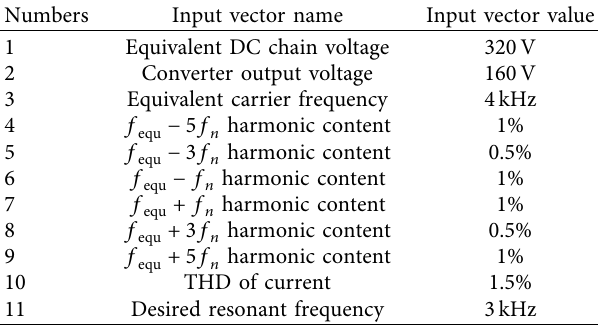
Table 2: Improved PSO-LSSVM model input vector.